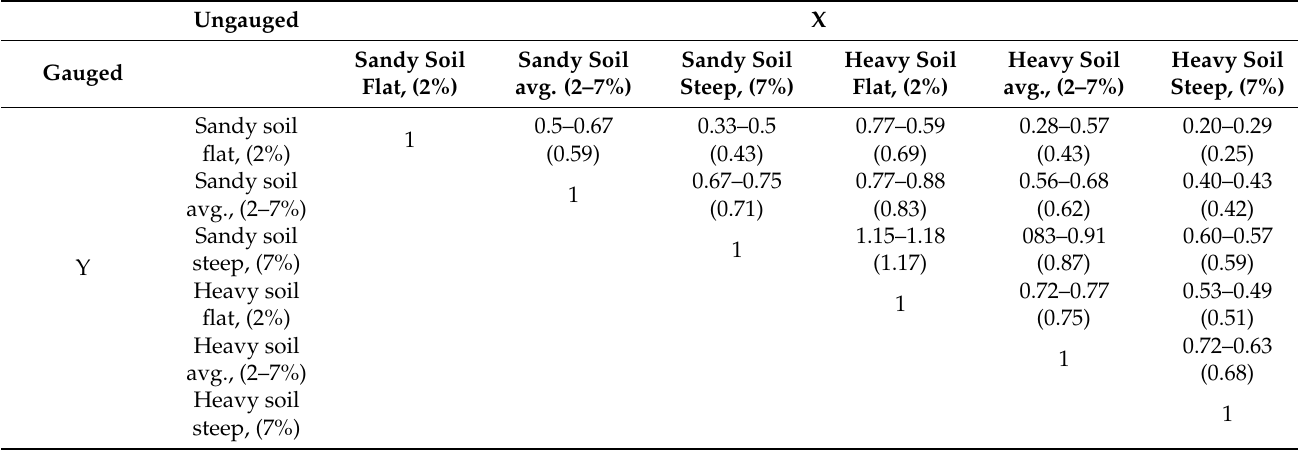
Table 3. C X /C Y